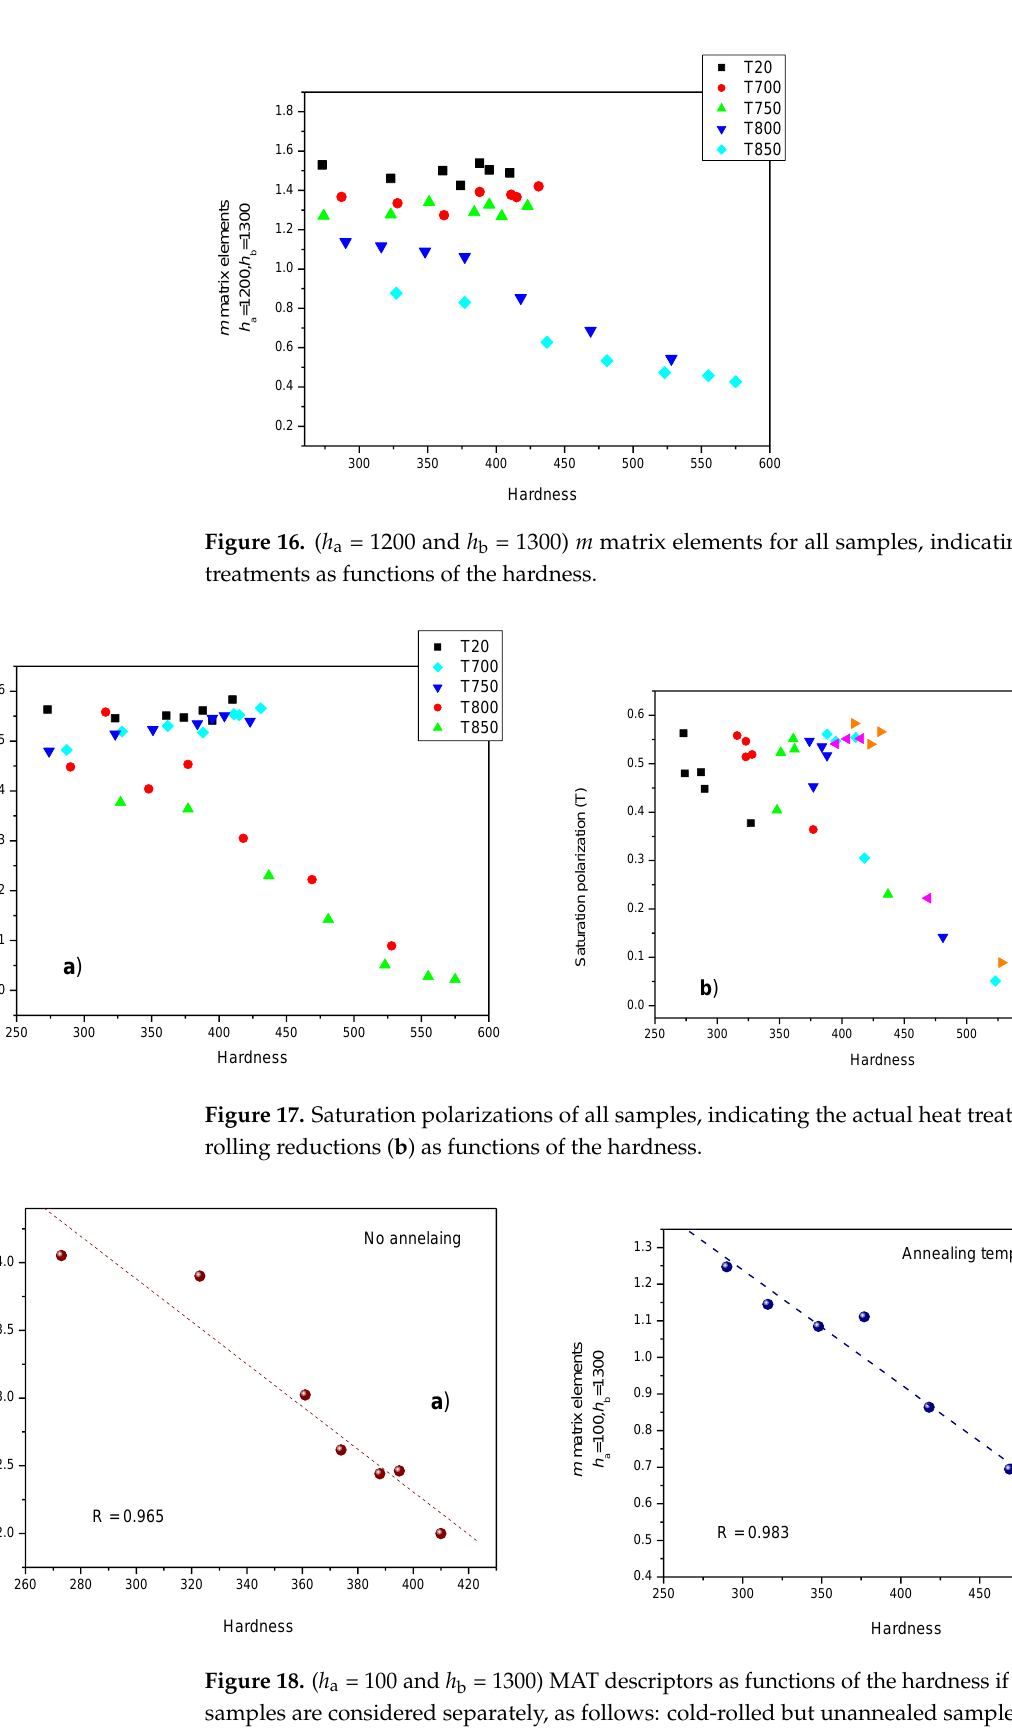
Figure 15. ( h a = 100 and h b = 1300) m matrix elements for all samples, indicating the actual heat treatments as functions of the hardness ( a ) and indicating the actual rolling reductions ( b ).